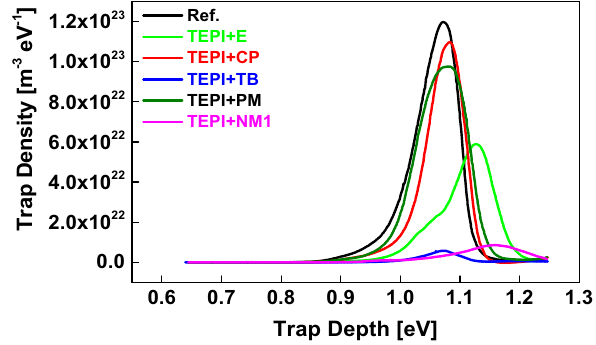
Figure 13: Calculated trap density and depth of the nanocomposites fi lled with the reference silica and the modi fi ed silicas.